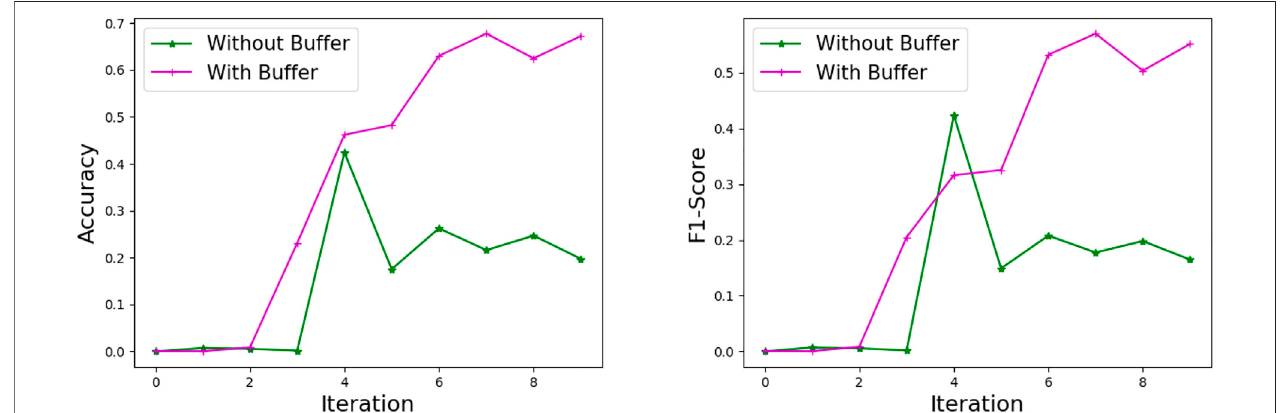
FIGURE 13 | The Accuracy and F 1 — Score performance of multi-class unknown anomalies in different increments.